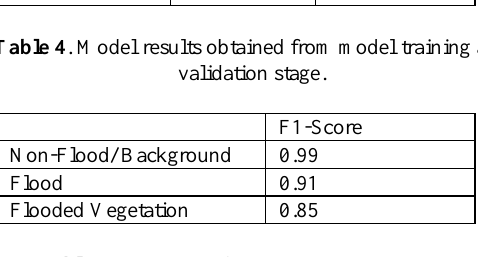
Table 5 . F1-Score of each class in the test data.